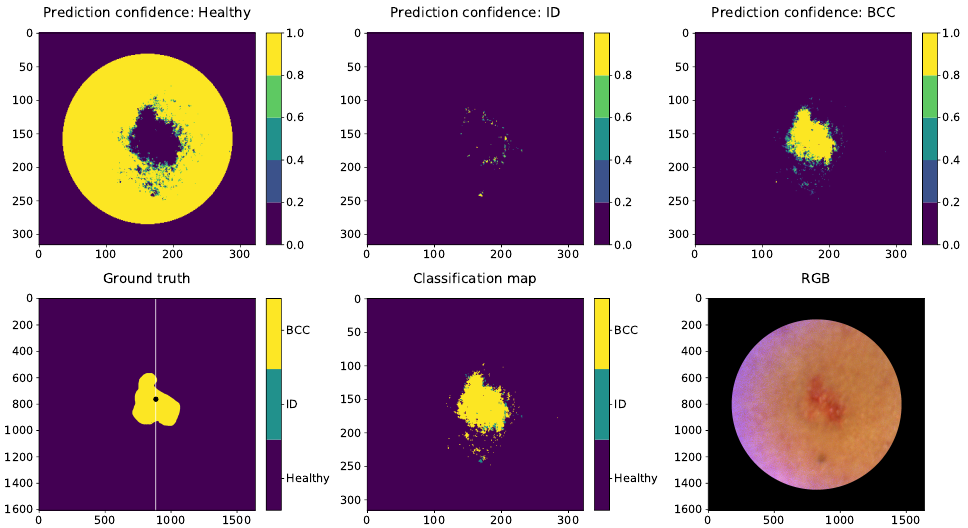
Figure 18. Nodular and superficial BCC visual pixel spectra classification example. First row: Healthy skin prediction confidence, prediction confidence of the ID and the prediction confidence of the BCC. Second row: The ground truth. The white line in the ground truth image shows the slicing position. The training data were collected as windowed (30 × 30 × 34) HS-sub-cubes. The middle pixels of those HS-sub-cubes (250 lesion and 100 healthy skin pixels) were randomly selected from the left sides of the lesions. The middle image is the classification map of this BCC HS image. “RGB” illustration of the lesion is on the right. The lesion was captured from the left upper arm. The unit of measures is smaller with prediction maps since the HS images were windowed with 5 pixels